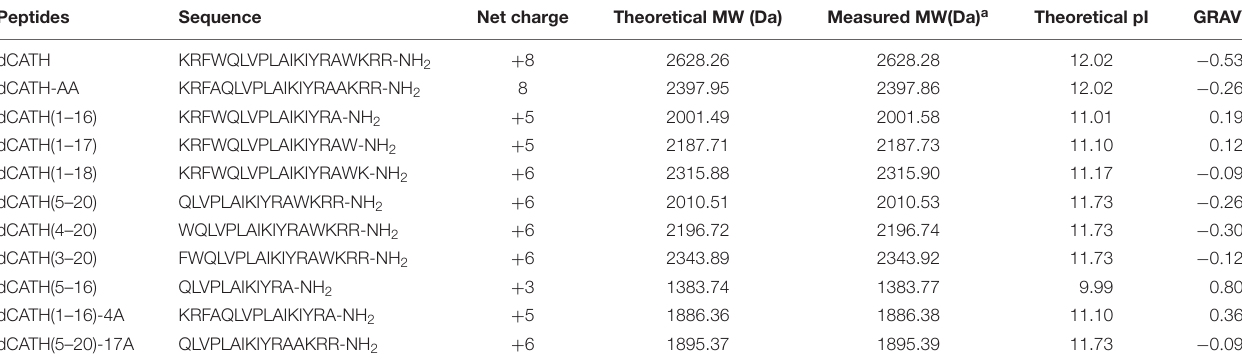
TABLE 1 | Amino acid sequences, charge, length, molecular weights, and the hydropathicity values of the peptides used in this study.